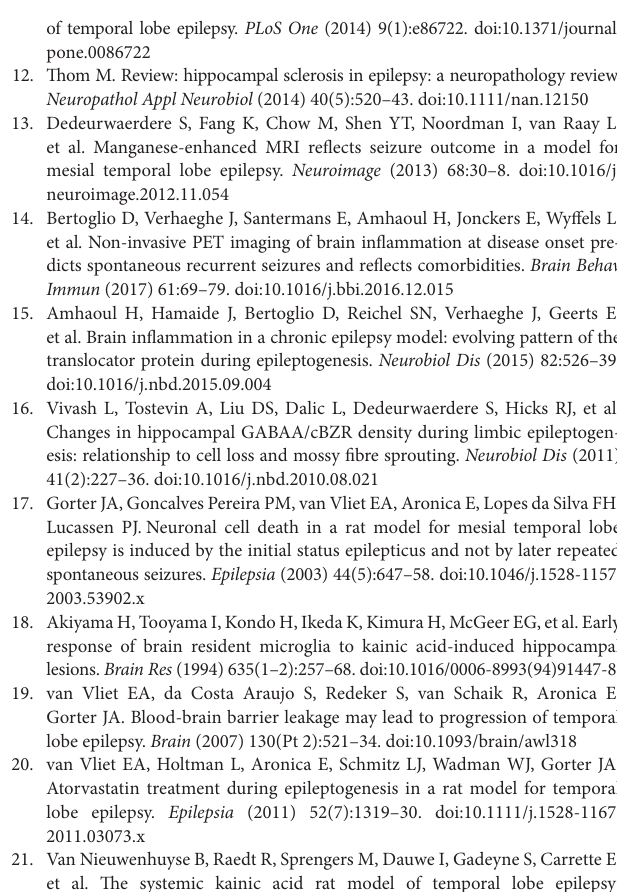
FigUre s1 | Representative delineation of the investigated regions. FigUre s2 | TSPO-specific binding 1 week post-SE in WH/CR and SD/H rats. For all brain regions and for both strains studied, a significant difference could be demonstrated between control and KASE animals 1 week post-SE. Kruskal–Wallis test with post hoc Dunn’s test. * p < 0.05, ** p < 0.01, *** p < 0.001. KASE, kainic acid-induced status epilepticus ; TSPO, translocator protein; status epilepticus, SE. FigUre s3 | TSPO-specific binding 12 weeks post-SE in WH/CR and SD/H rats. In the KASE WH/CR animals, increased TSPO-specific binding 12 weeks post-SE could only be demonstrated in the CA1 when compared to control WH/CR rats. On the contrary, KASE SD/H rats showed a significant increase in all regions investigated compared to control SD/H animals. Kruskal–Wallis test with post hoc Dunn’s test. * p < 0.05, ** p < 0.01, *** p < 0.001. KASE, kainic acid-induced status epilepticus ; TSPO, translocator protein; status epilepticus, SE. FigUre s4 | The number of fluorojade C (FjC)-positive cells inversely correlated with the number of neurons 1 week post-status epilepticus in WH/CR and SD/H rats. A statistically significant correlation between the number of FjC-positive cells and neurons was determined in all investigated regions. Spearman’s rank test. FigUre s5 | The number of fluorojade C (FjC)-positive cells correlated with the % area of OX-42 1 week post-status epilepticus in WH/CR and SD/H rats. A statistically significant correlation between the % area of OX-42 and the number of FjC-positive cells was determined in all investigated regions. Spearman’s rank test.